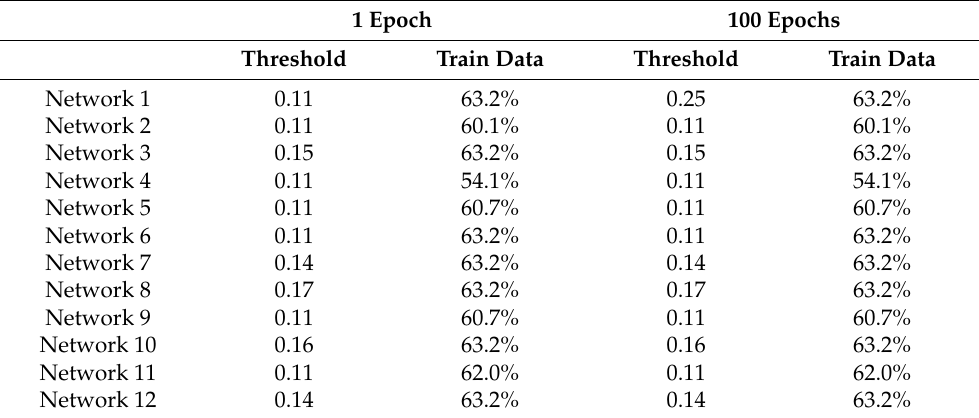
Table 4. Threshold values and performance with training data for 1 and 100 training